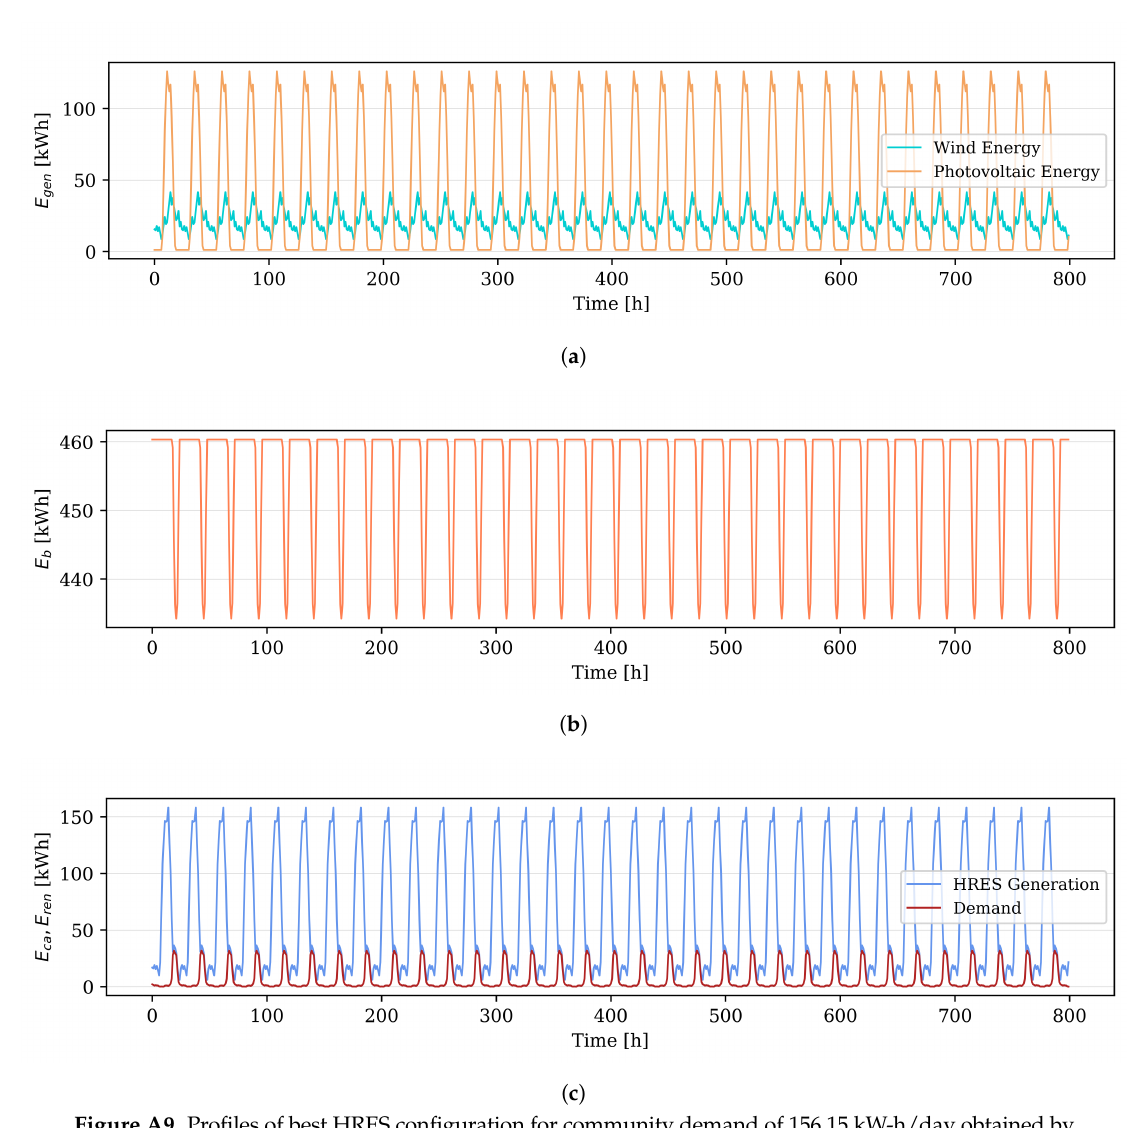
Figure A9. Profiles of best HRES configuration for community demand of 156.15 kW-h/day obtained by multi-objective function with LCOE , N wt ,1 = 11, N wt ,2 = 45, N pv ,1 = 240, N pv ,2 = 93, N pv ,3 = 291, N b = 341. ( a ) Total renewable energy generation. ( b ) Storage system state. ( c ) HRES generation vs.